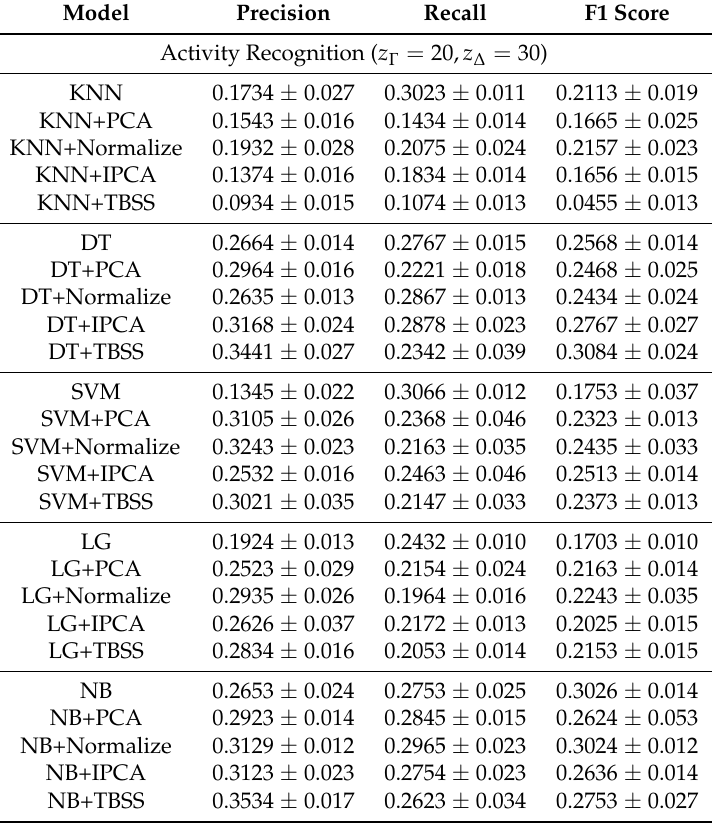
Table 4. The performance of TBSS and other pre-processing methods on activity recognition